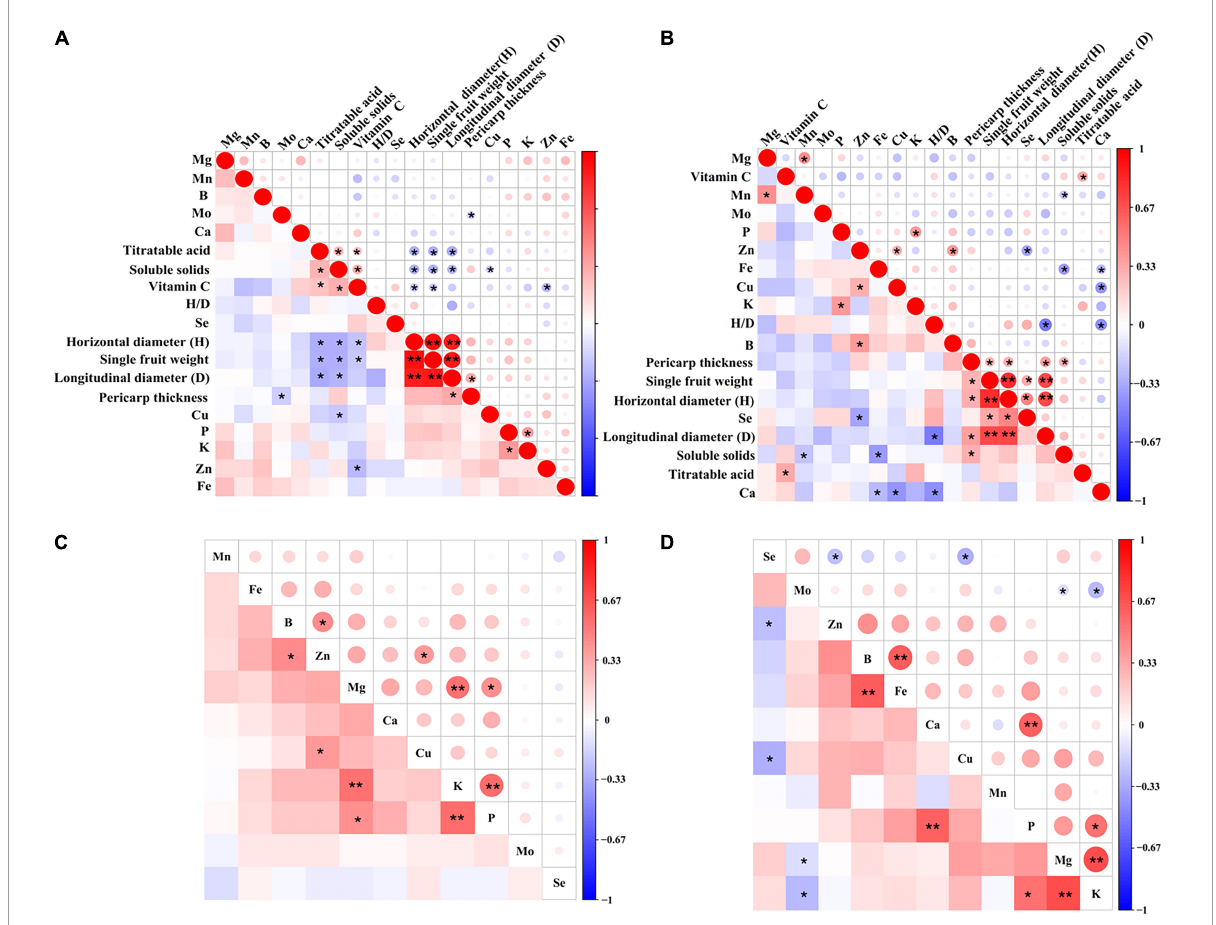
FIGURE4 Correlation analysis of Se with its quality indicators and mineral elements in ordinary navel orange fruit (A) and flesh (C) and Se-rich navel orange fruit (B) and flesh (D) in southern Jiangxi (* p < 0.05, ** p <